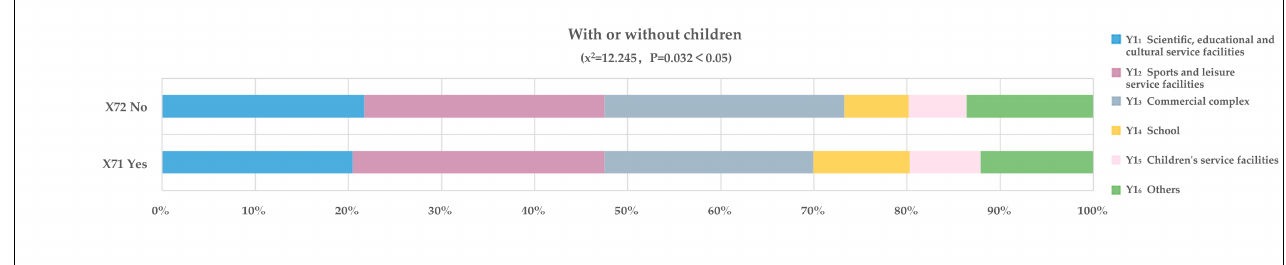
Figure 12. Demand from people with and without children.